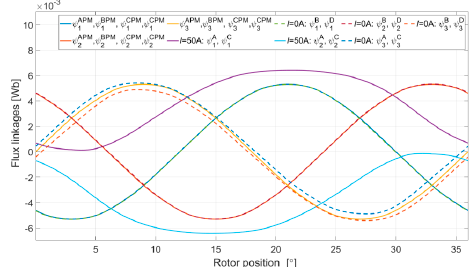
Figure 9. Flux linkages vs. rotor positions for DCO A and C—variant II.